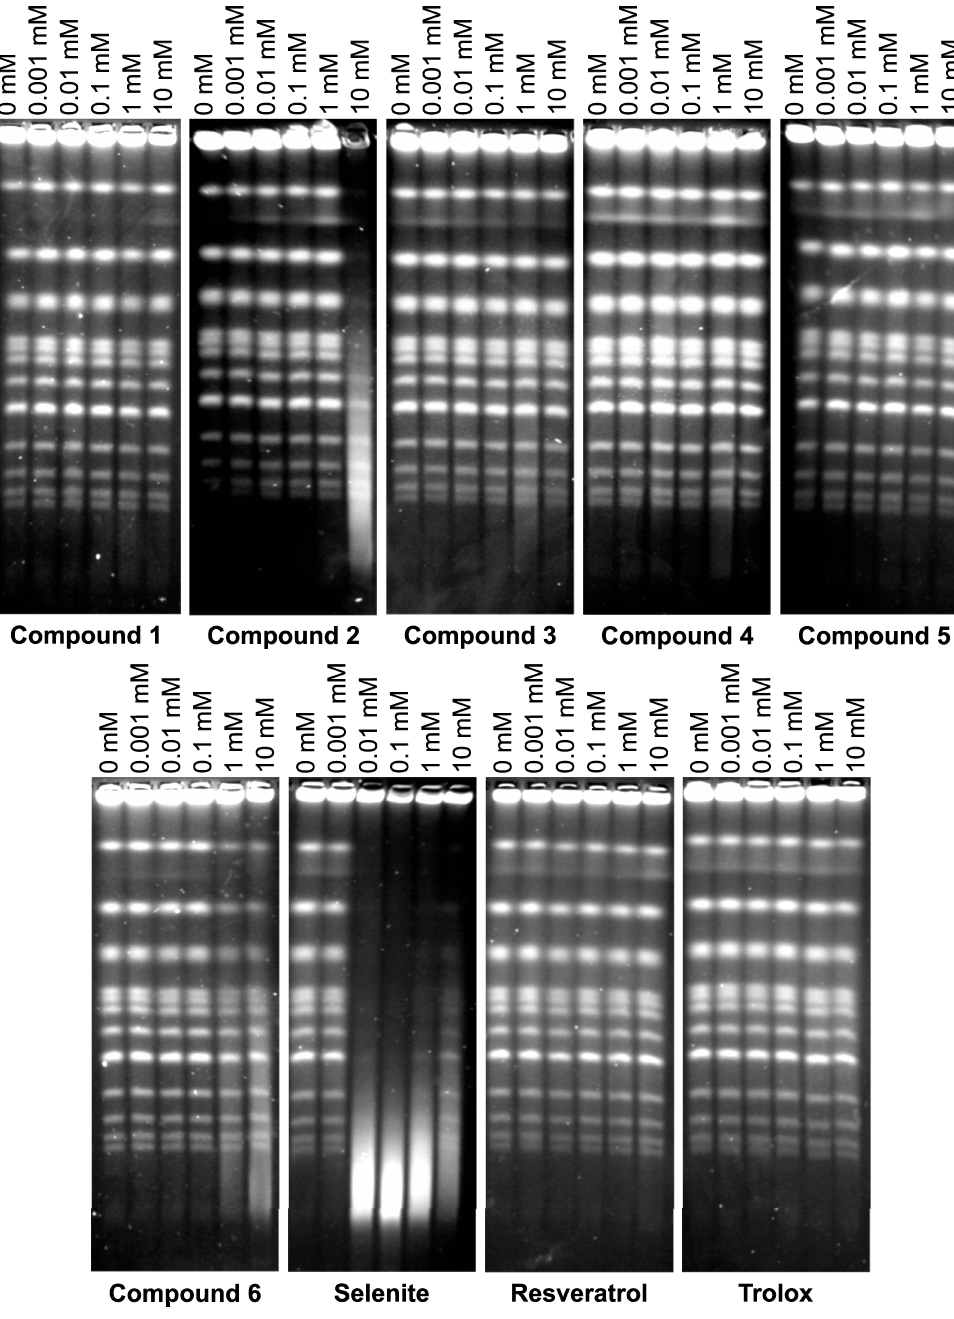
Figure 4. DSBs induction by resveratrol–inspired benzo[ b ]selenophenes in S. cerevisiae . Representative gels are shown.